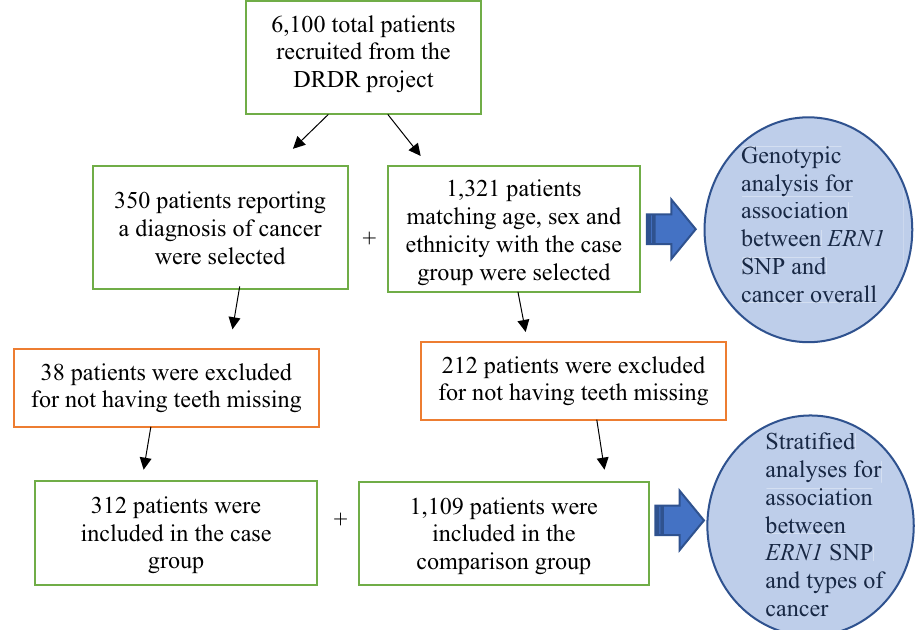
Figure 1. Overall study design.